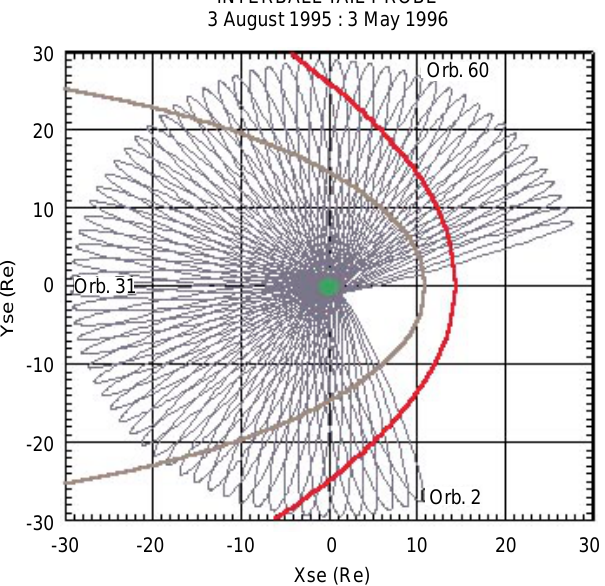
Fig. 3. Orbits 2 (3 August 1995) to 74 (3 May 1996) of the Tail Probe projected onto the ecliptic plane. Average models of the Earth’s bow shock and the magnetopause are indicated by the red and brown curves